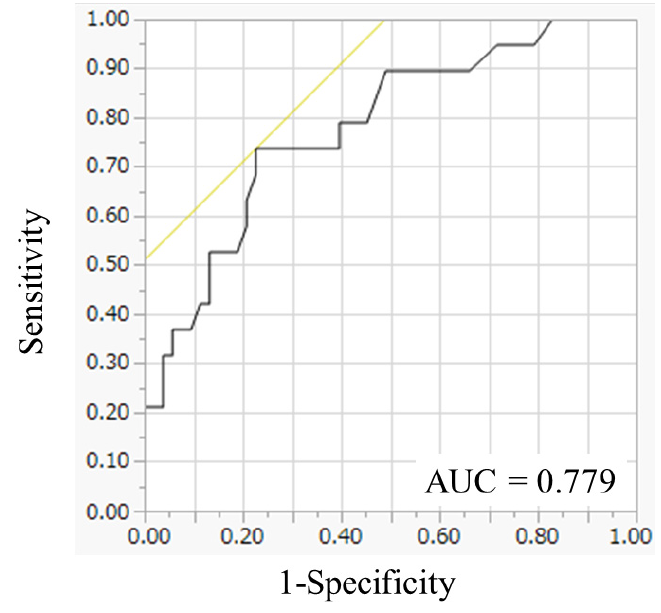
Figure 1. Receiver operating characteristic curve analysis of tumor diameter in the greatest dimension. The area under the curve for tumor diameter in the greatest dimension was 0.779. Table 2 classifies the patients by clinical tumor size at diagnosis. The mean and me-